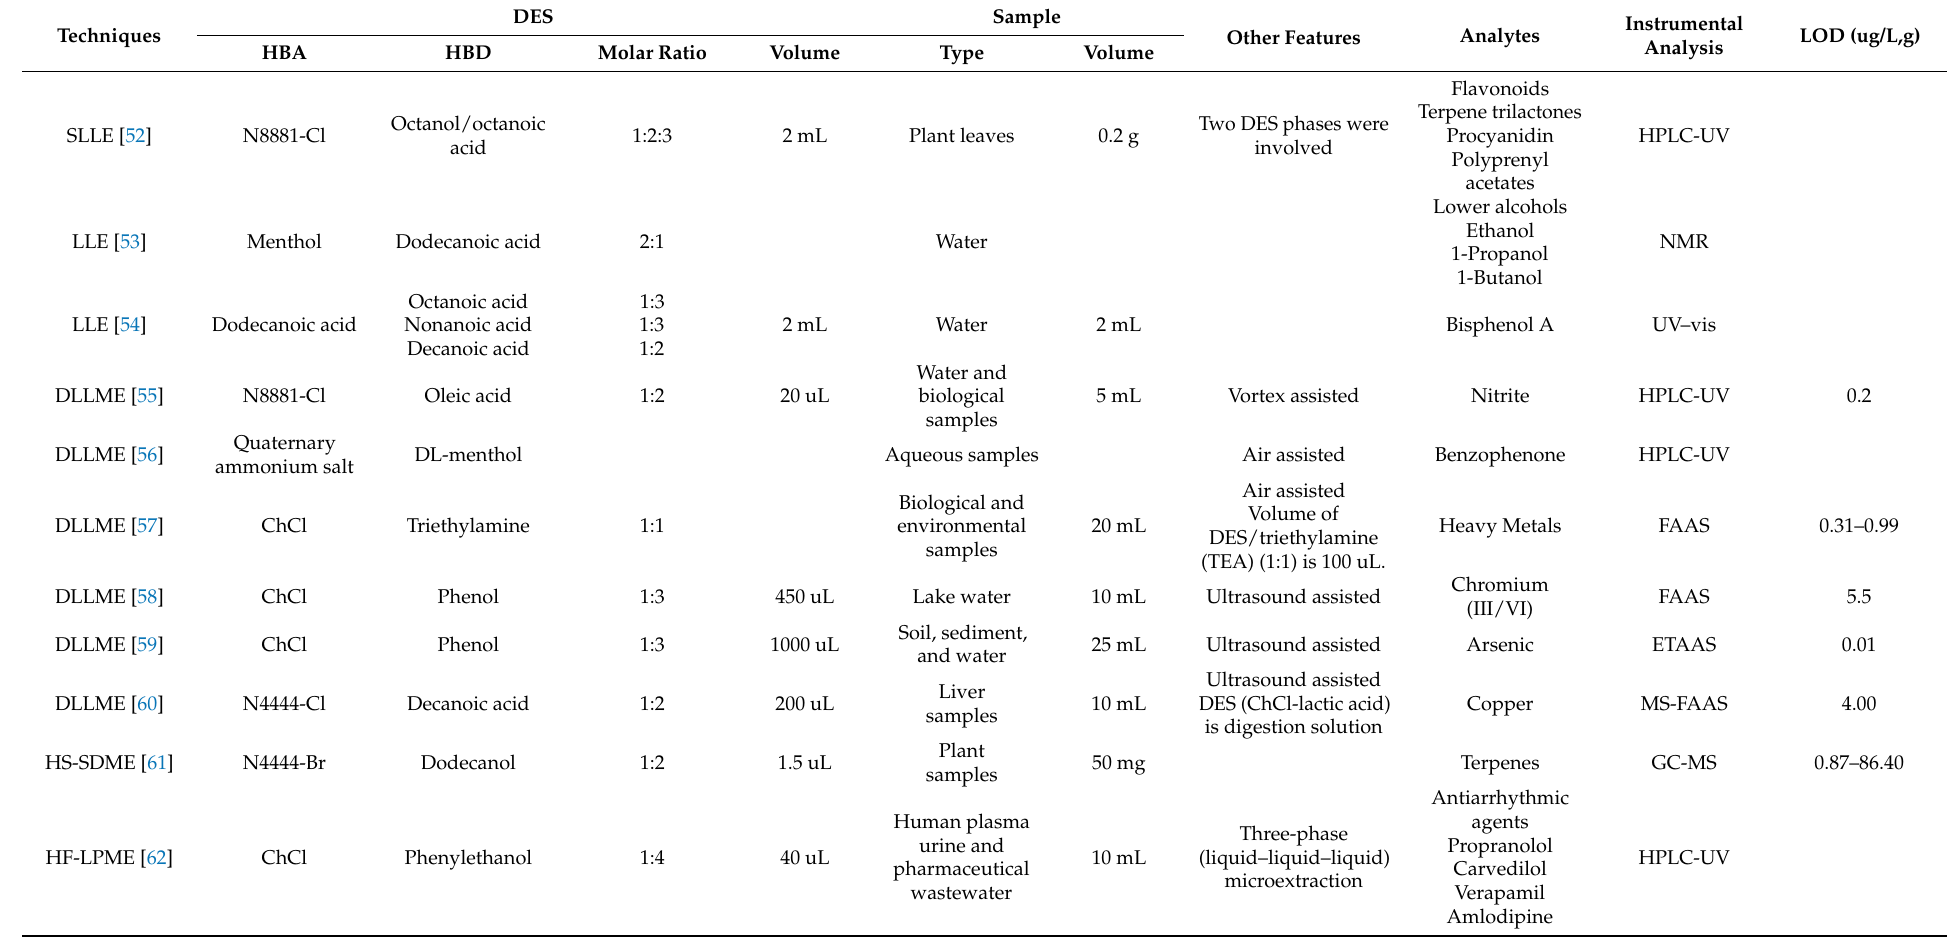
Table 1. Extraction technique combined with DESs in environmental